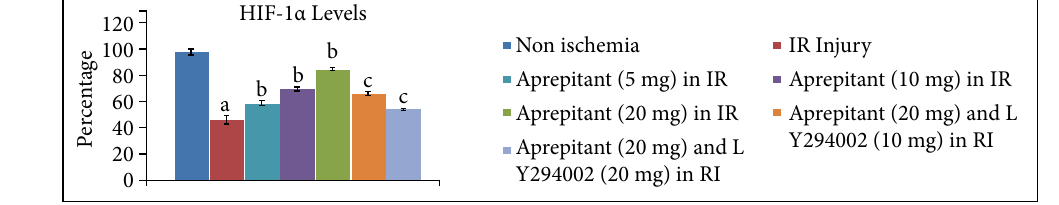
Figure 3 - Effect of aprepitant and LY294002 on ischemia-reperfusion-induced changes in HIF-1 α in the heart homogenate. Values are given as mean ± SD. (a) p < 0.05 vs . non-ischemia;